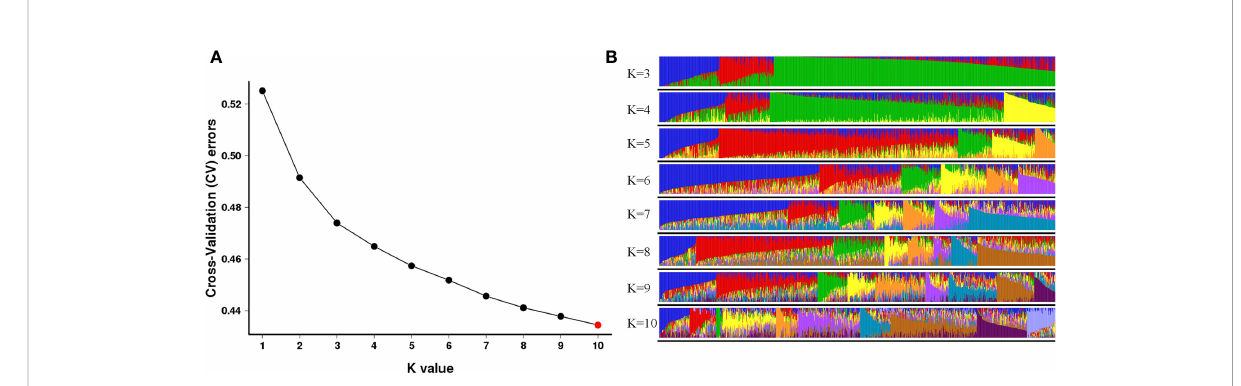
FIGURE 3 Population structure analyses of O. ru fi pogon accessions using ADMIXTURE. (A) Cross-validation plot for the number of population ( K ) values; (B) Model-based clustering with K values from 3 to 10. The colours represent different populations of the 998 wild rice